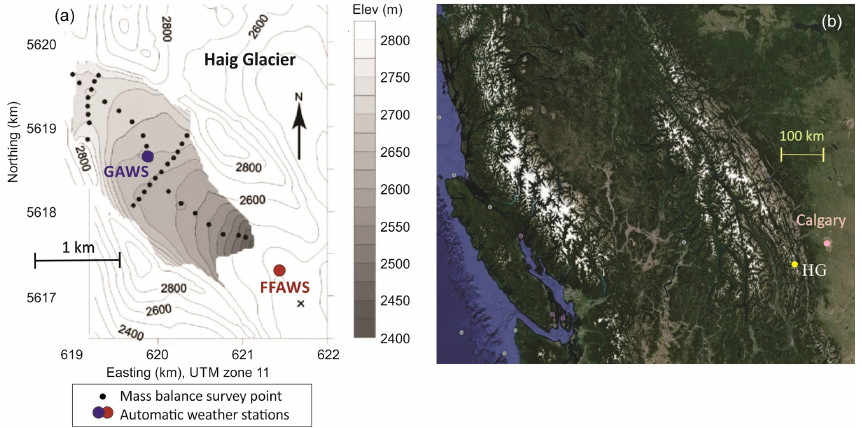
Figure 2. (a) The topography and automatic weather stations on Haig Glacier (GAWS) and the glacier forefield (FFAWS). The smaller black dots are mass balance survey points. (b) The location of Haig Glacier is labelled HG on the Google Earth map of southwestern